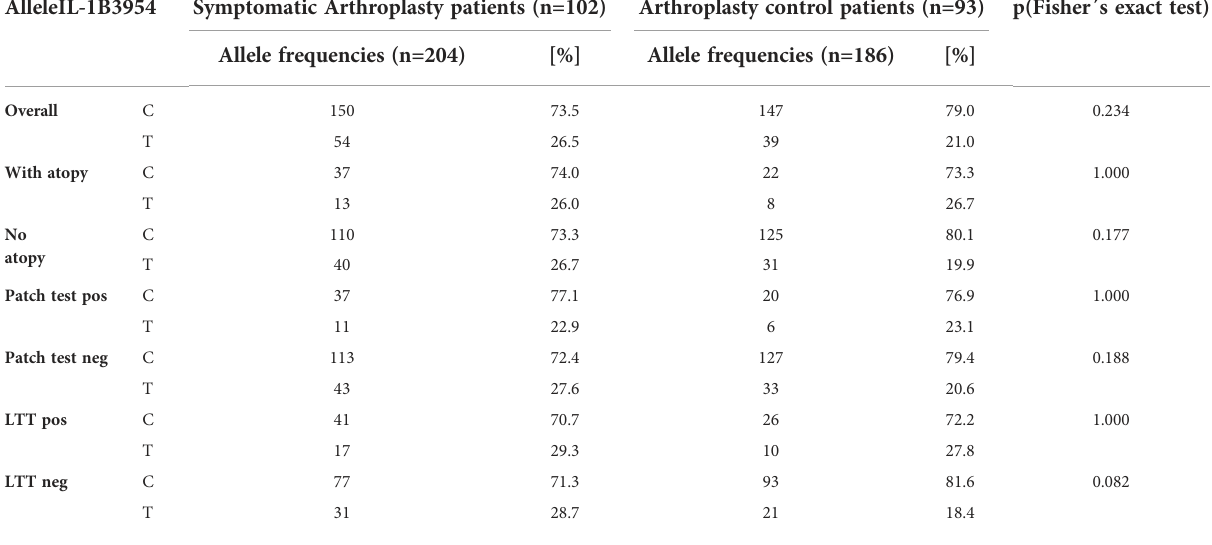
TABLE 4 Allele frequencies of the IL-1B-3954 polymorphism including also subgroup analysis.